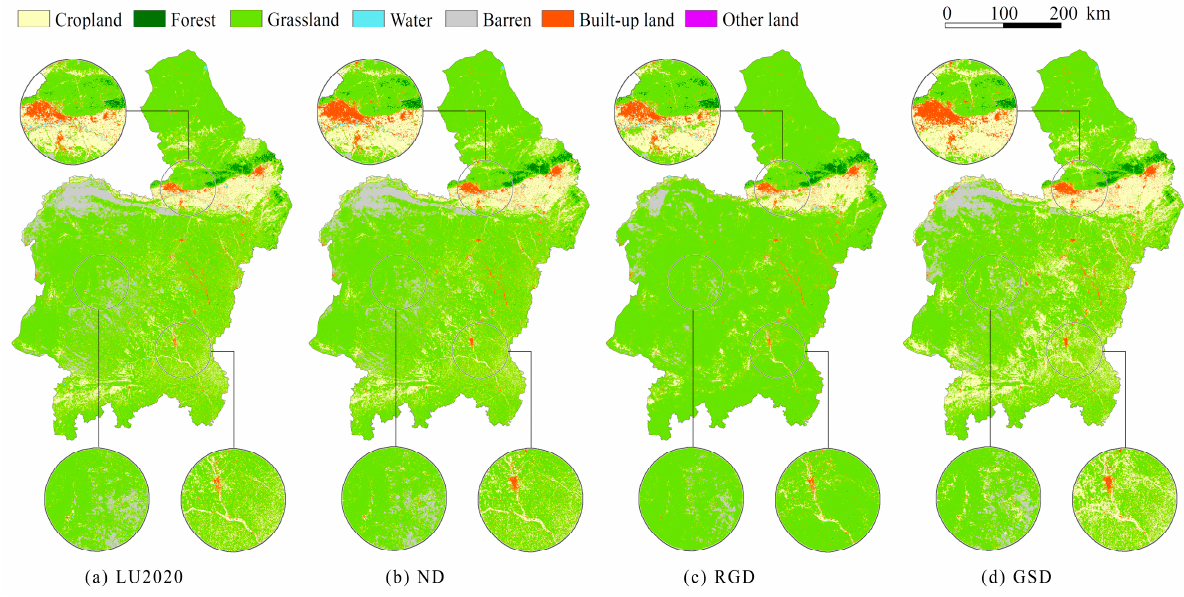
Figure 9. Land use patterns in 2020 ( a ), ND scenario ( b ), RGD scenario ( c ) and GSD scenario ( d ).